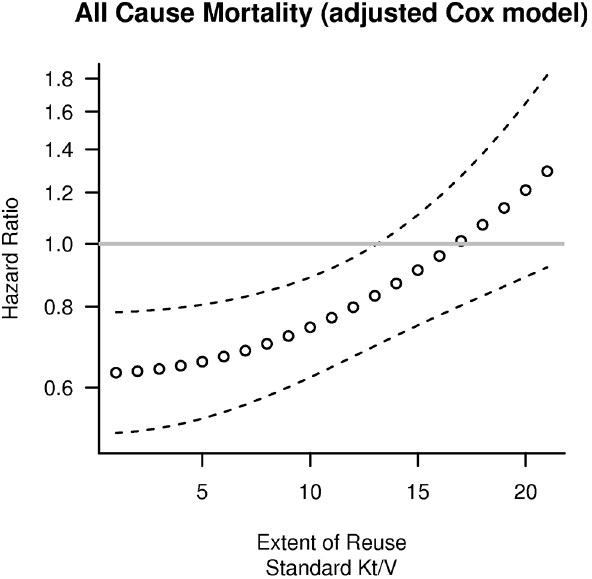
Fig 5. Predicted Hazard Ratio (HR) of High Flux(HF) dialysis as a function of membrane reuse. Predictions were obtained by fitting a meta-regression model to adjusted (for age, gender, diabetes, vascular access and comorbidity score) HR of subgroups of HEMO (defined on the basis of reuse quartiles, Kt/V and flux) and MPO. The meta-regression model accounted for Kt/V and the (square) of the extent of reuse. Of note, reuse of HF membranes up to 13 times appears to yield a protective effect with a predicted RR of 0.83, and an associated 95% CI: 0.70 – 0.99 that excludes unity.